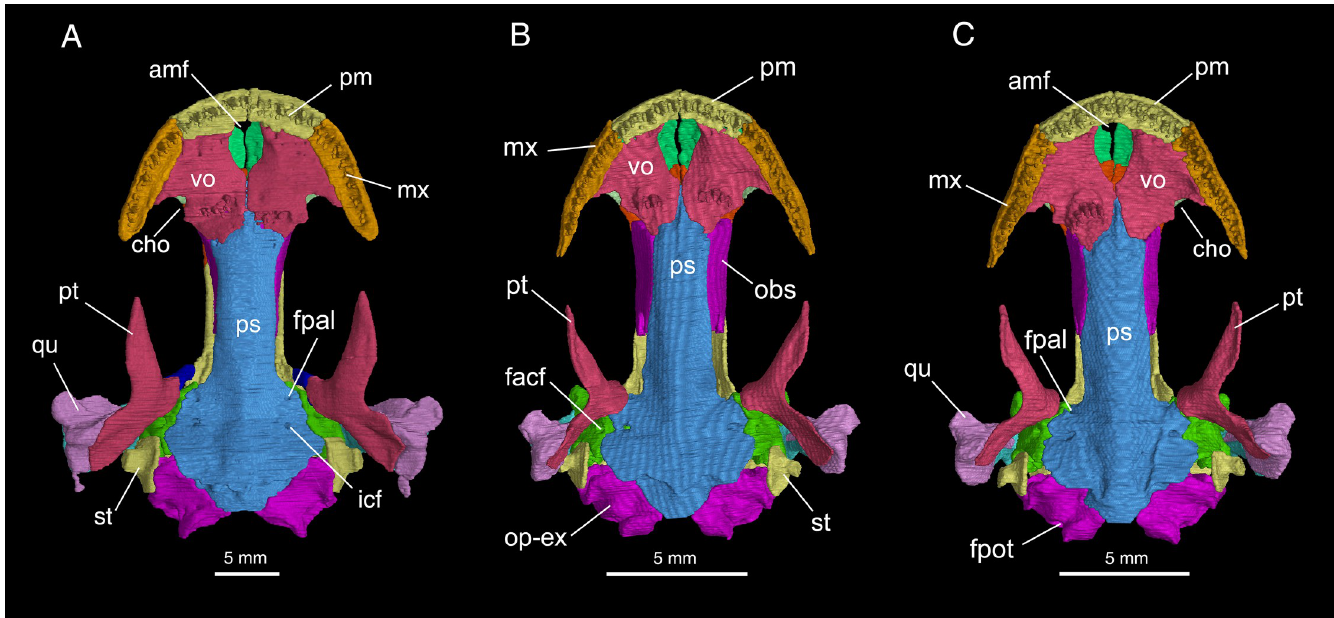
Fig 5. Micro-CT rendered reconstruction of the skull of Batrachuperus yenyuanensis in palatal view. A, CIB 72599 from Tuowu, Mianning County; B, FMNH 49371, paratype specimen from Shuangertang, Yanyuan County; C, CIB 17308 from Shuangertang, Yanyuan County.